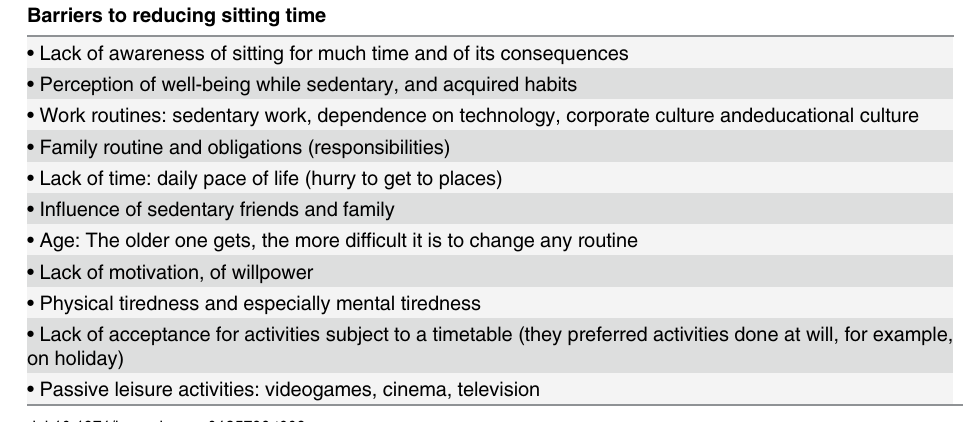
Table 3. Main barriers to reducing sitting time. Barriers to reducing sitting